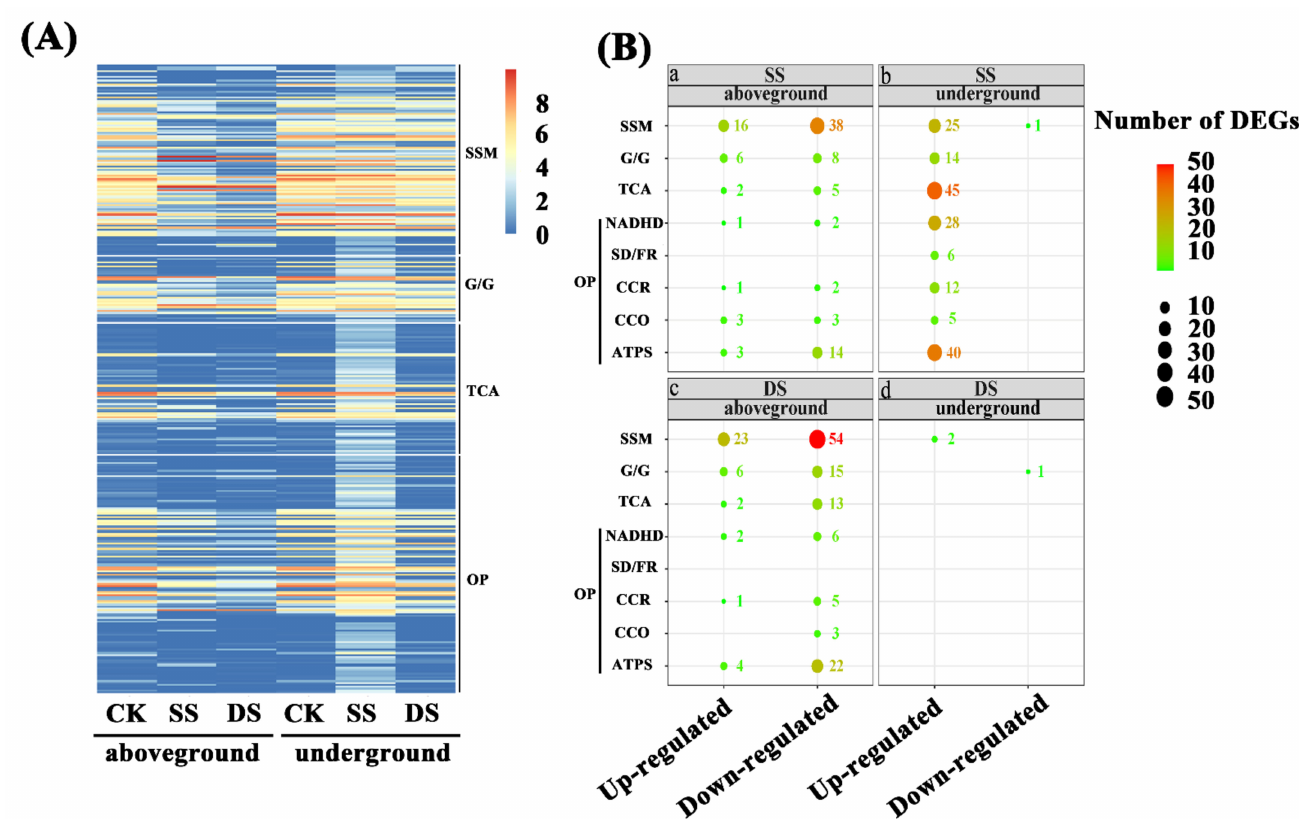
Figure 4. Differentially expressed genes (DEGs) related to energy metabolism in aboveground and underground tis- sues of bermudagrass. ( A ) Heatmap of DEGs expression profiles under control (CK), shallow submergence (SS), and deep submergence (DS). The x axis represents different treatments. The y axis represents the value of relative ex- pression level (log 2 (FPKM + 1)). ( B ) The number of DEGs expression under SS and DS. Point size correlates with the number of DEGs. FPKM: fragments per kilobase of transcript per million mapped reads; SSM: starch and su- crose metabolism; G/G: glycolysis/gluconeogenesis; TCA: TCA cycle; NADHD: NADH dehydrogenase; SD/FR: suc- cinate dehydrogenase/fumarate reductase; CCR: cytochrome c reductase; CCO: cytochrome c oxidase; ATPS: ATP synthase; OP: oxidative